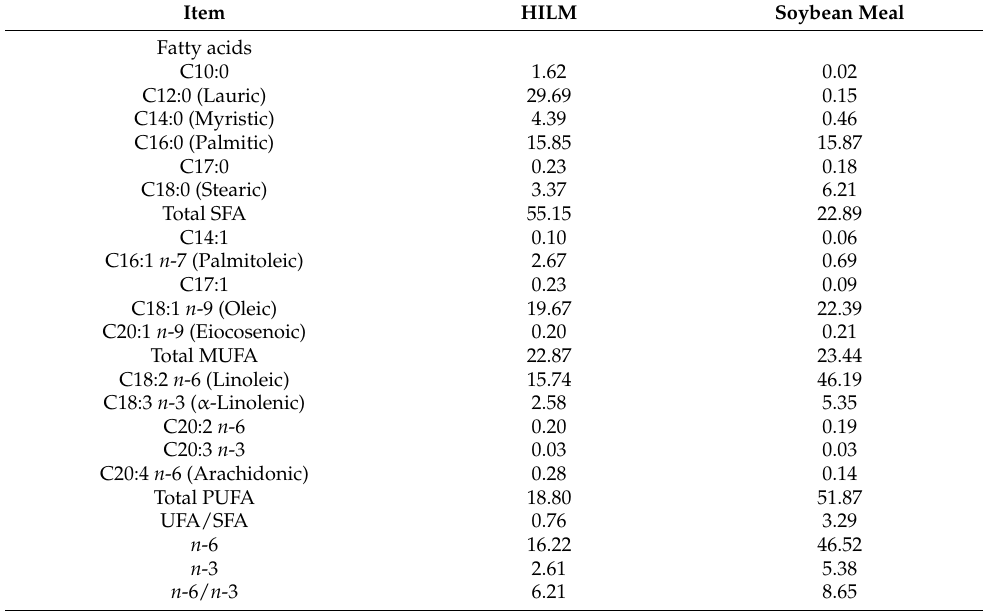
Table 3. Fatty acid profile (% of total fatty acid methyl esters) of Hermetia illucens larvae meal (HILM) and soybean meal.